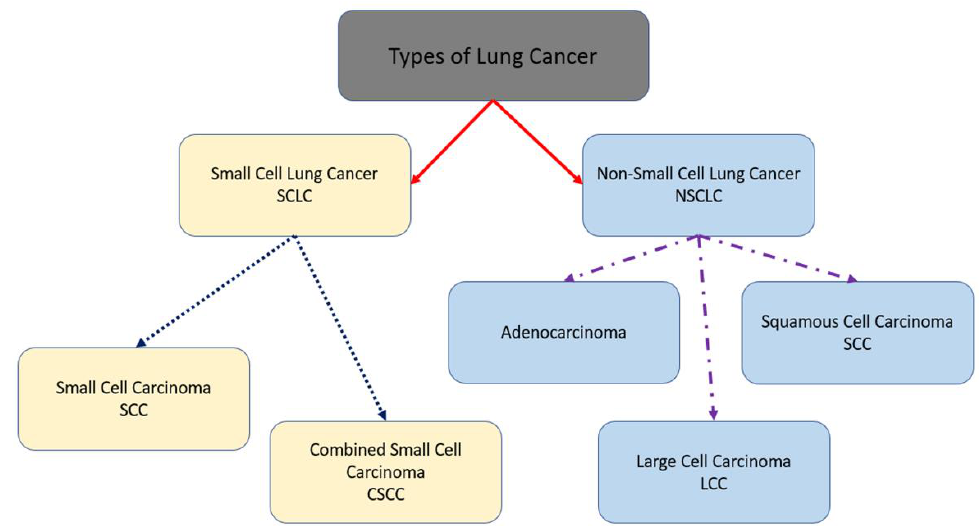
Figure 1. Types of lung